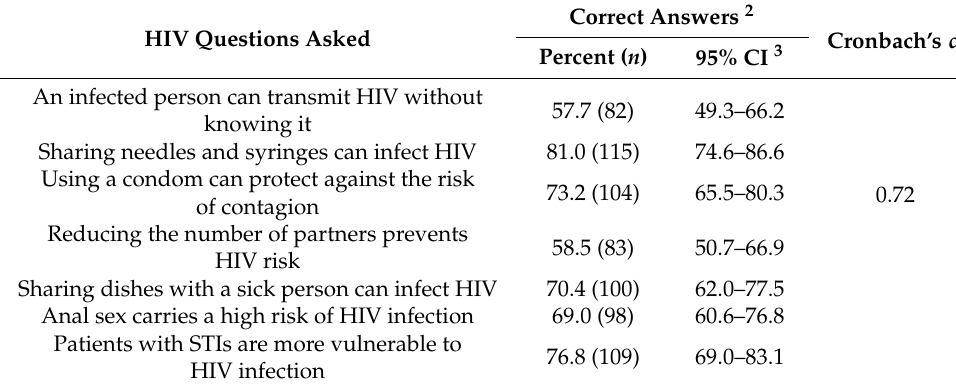
Table 2. HIV-related knowledge 1 in interviewed men who have sex with men, Manzanillo, Mexico ( n = 142).